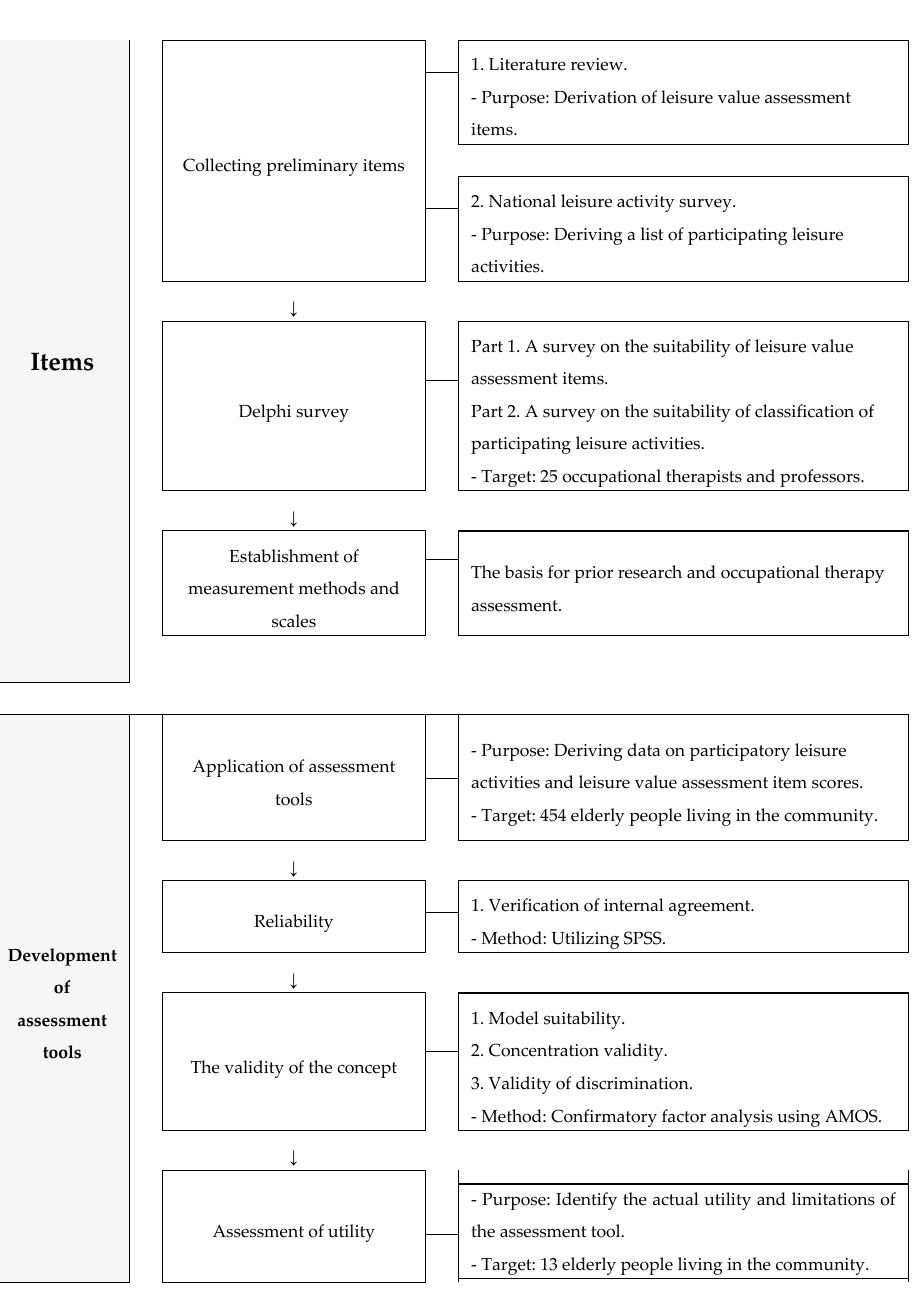
Figure 1. Research process and assessment tool development process. Table 1. Classification and definition of leisure activities for the